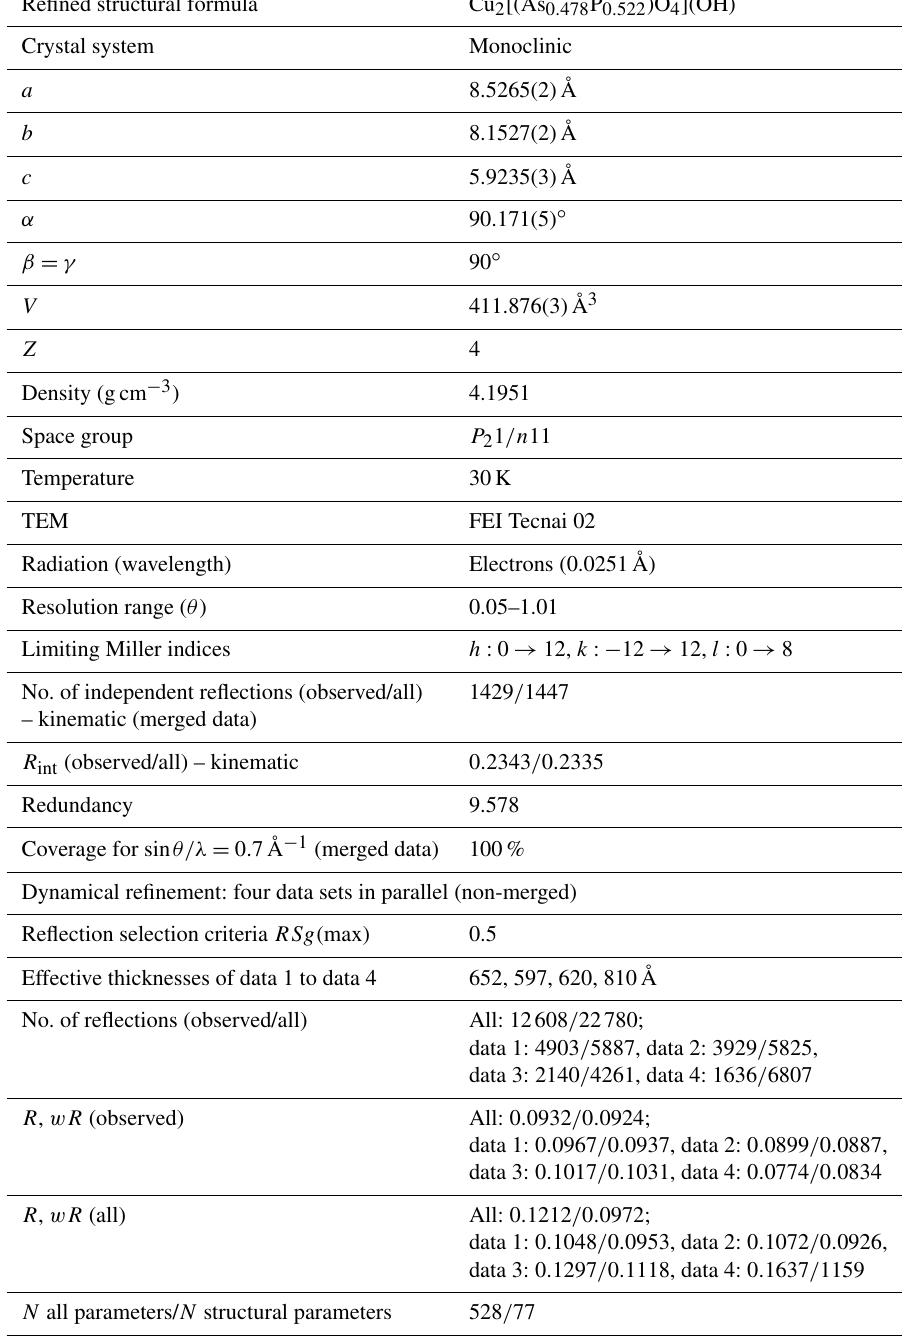
Table 4. 3D ED data collection and structure refinement details for the olivenite–libethenite solid-solution series sample 50P50As. Refined structural